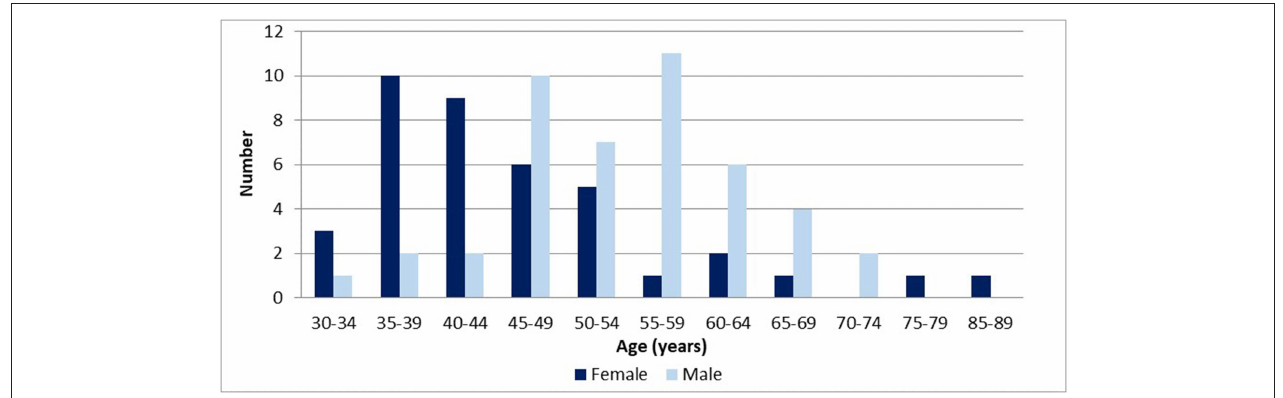
FIGURE 2 | Age of respondents by gender ( n =